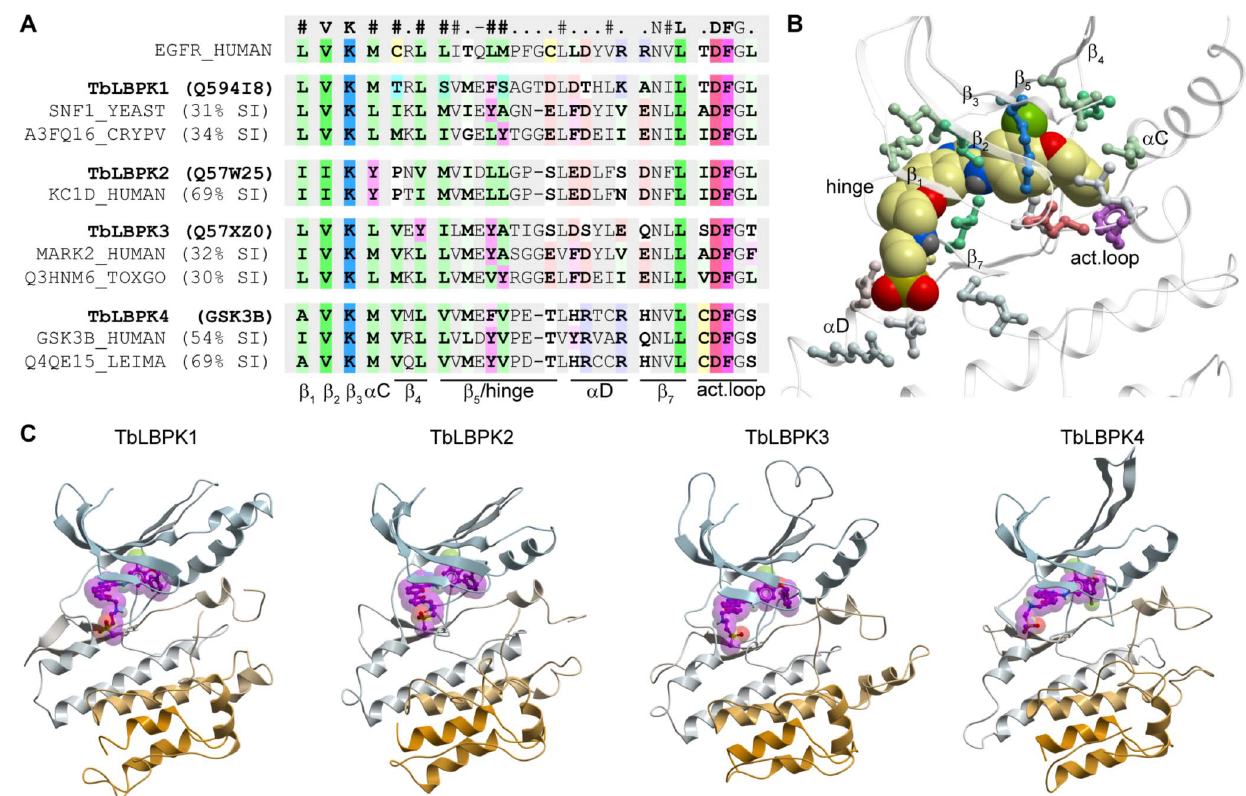
Figure 4. Closest homology templates for TbLBPK1 (magenta) and TbLBPK3 (navy) are crystallographically observed in a conforma- tion similar to that of lapatinib-bound human EGFR (white).